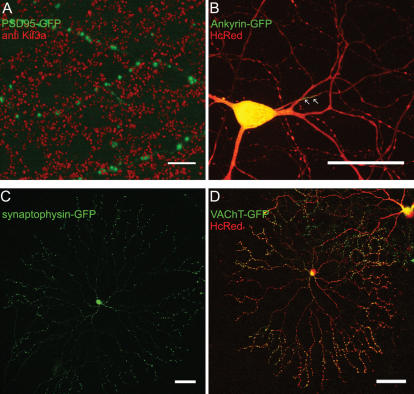
Pre- and postsynaptic markers and ankyrin-G are correctly localized in transfected retinal neurons.(A) High-power view of several dendrites of a retinal ganglion cell transfected with PSD95-GFP (green) and counterstained with an antibody against the synaptic ribbon component Kif3a (red). Most PSD95 puncta are in close proximity to one or more synaptic ribbons. Scale bar, 10 µm. (B) Ankyrin-G-MB-GFP (green) and HcRed (red) were transfected into a retinal ganglion cell. HcRed labels the whole extent of the cell, whereas Ankyrin-G-MB-GFP is found in the initial segment of the axon (arrows). Some Ankyrin-G-MB-GFP labeling is seen in the soma and the primary dendrites, the place of protein synthesis. Scale bar 50 µm. (C) Starburst amacrine cell transfected with an expression plasmid for synaptophsin-GFP. The known synaptic output sites of these cells, varicosities in the outer third of the dendritic tree are labeled with this marker. (D) Starburst amacrine cell transfected with expression plasmids for the cell-filling marker HcRed (red) and a fusion protein from the synaptic vesicle marker VAChT-GFP (green). Scale bar, 50 µm.